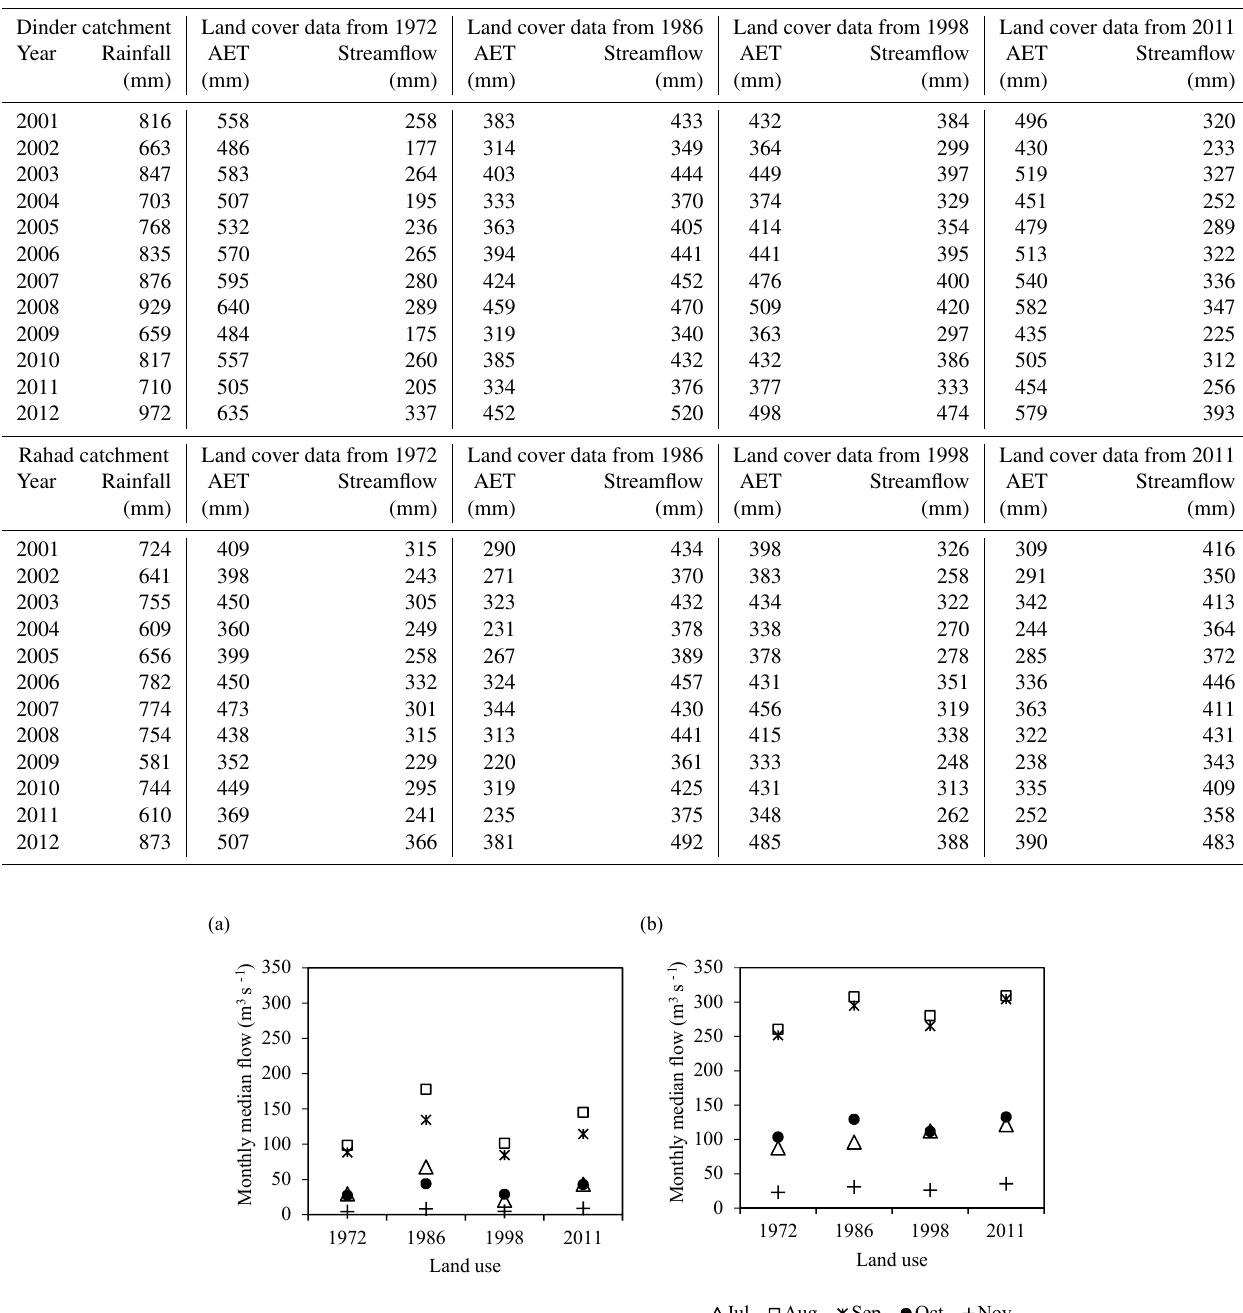
Table 6. Water balance of the Dinder and Rahad catchments applying different LULC data. Dinder catchment Land cover data from 1972 Land cover data from 1986 Land cover data from 1998 Land cover data from 2011